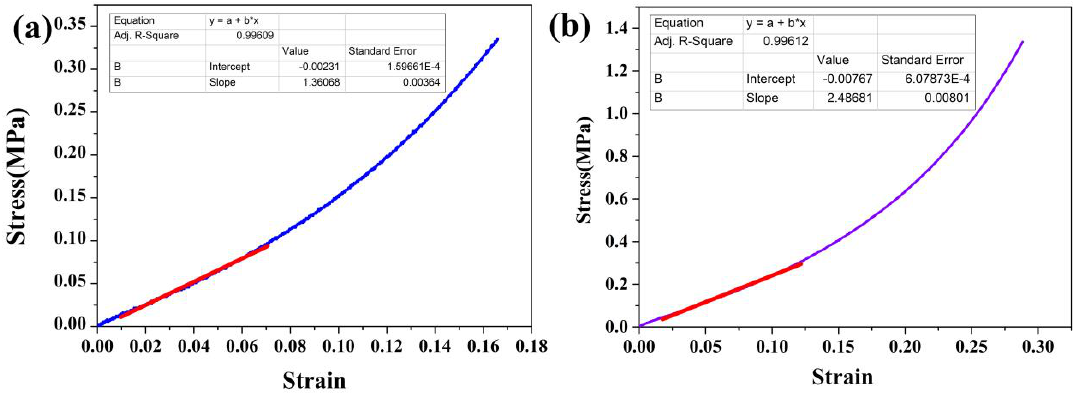
Figure 6. Stress-stain curve of the CO 2 -SPD aerogels before ( a ) and after ( b ) the first thermal shock.